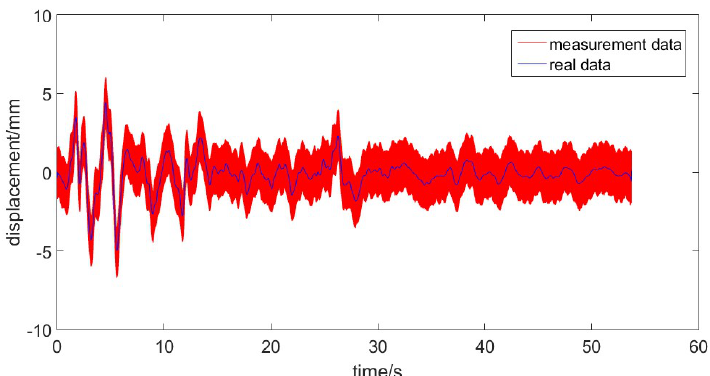
Figure 3. The real data and measurement